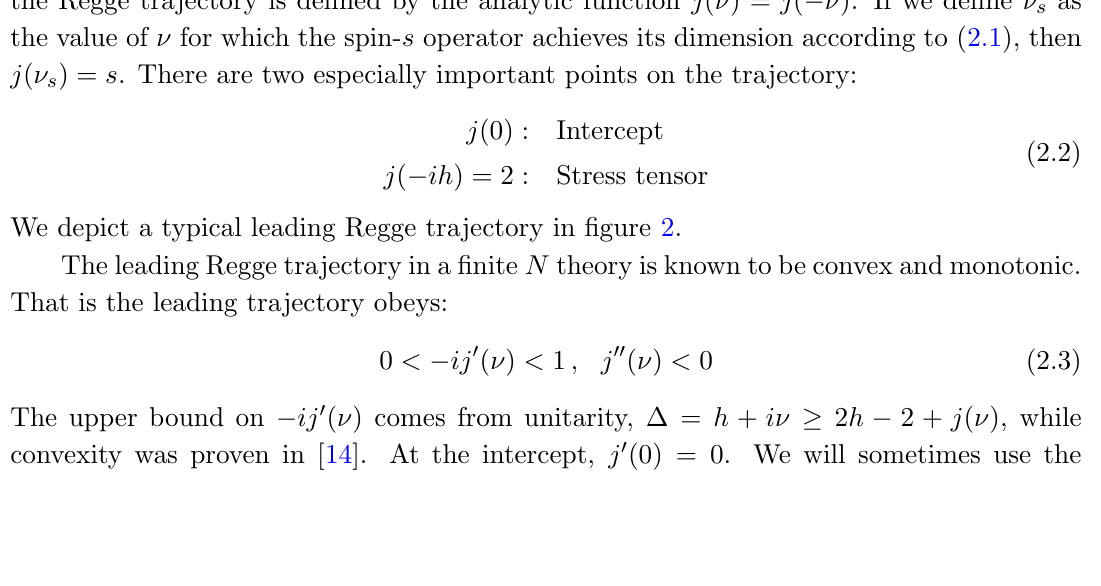
Figure 2 . A prototypical leading Regge trajectory, here depicted in d = 4. Recall that i(cid:23) (cid:17) (cid:1) (cid:0) d We have indicated the locations of the stress tensor, T , and the lightest spin-four operator, O 4 which de(cid:12)nes (cid:1) gap through j ( (cid:0) i ((cid:1) gap (cid:0) 2)) =